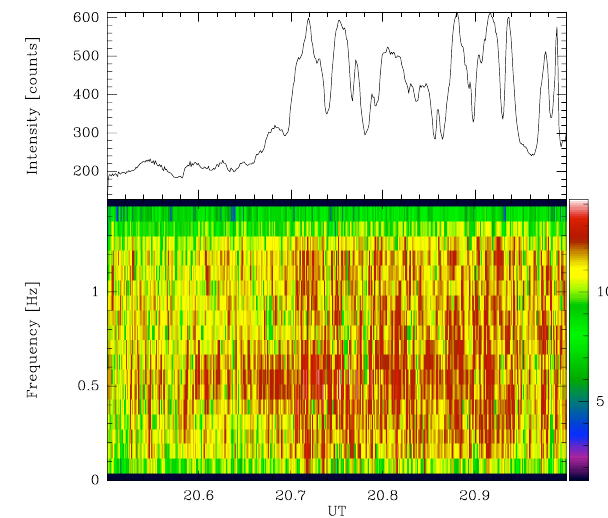
Fig. 6. Intensity of the red line and PSD (arbitrary unit) versus time during northward observations for the polarised channel.